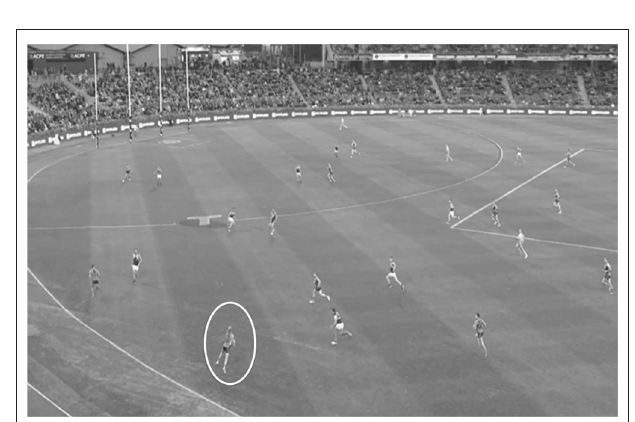
FIGURE 2 | An example of a critical decision-making moment, used for the film-based task. For this example, the player with the ball is circled for reference, with the team in the gray uniforms on